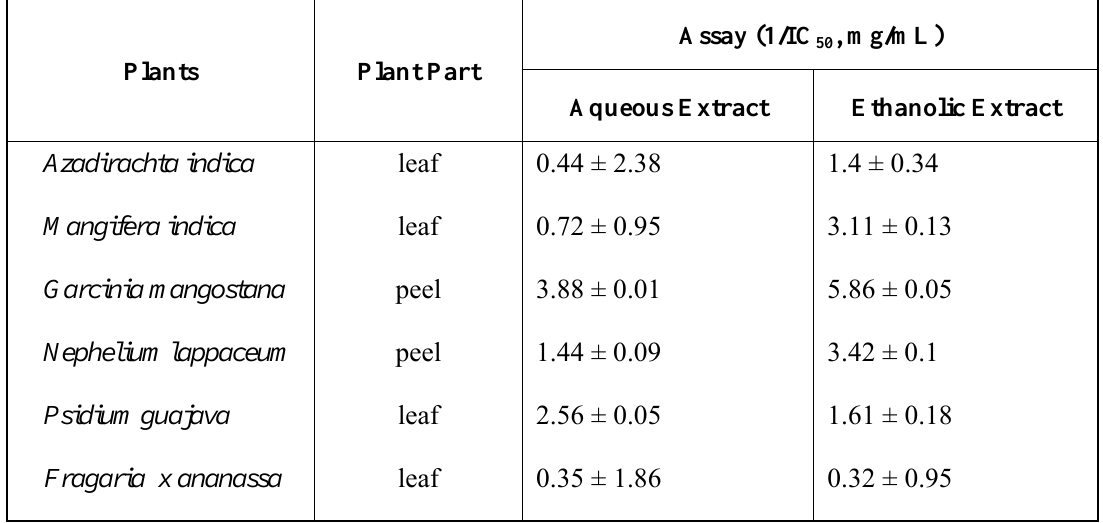
Table 4. Inhibition of lipid peroxidation of various extracted Malaysian plants in water and ethanol.